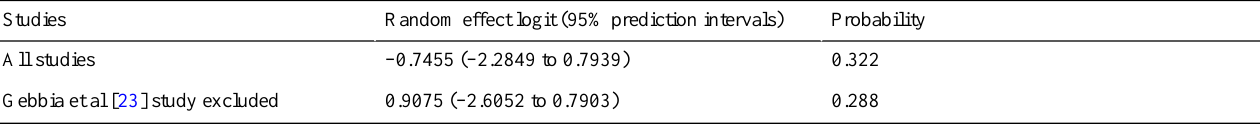
Table 3. Prediction intervals and probability of fear random effect in all studies and when Gebbia study is not